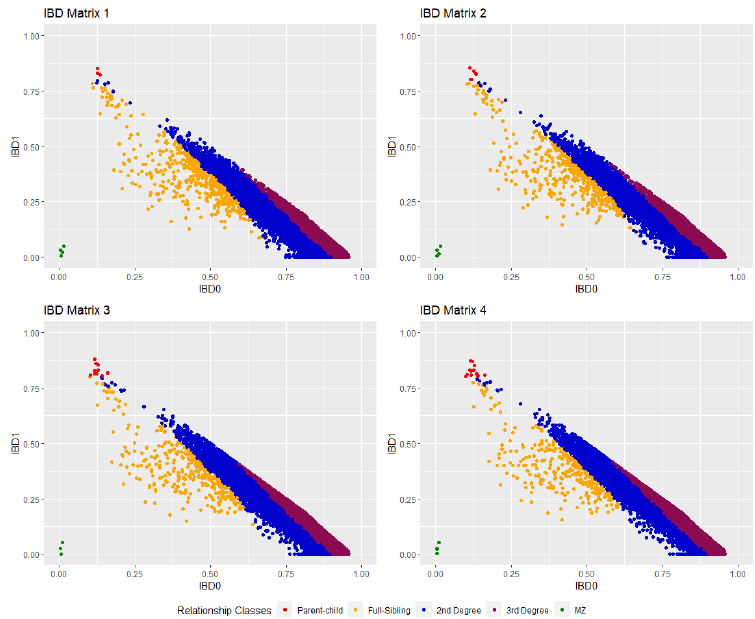
Figure 2. Distribution of relationship categories determined for the four IBD matrices.